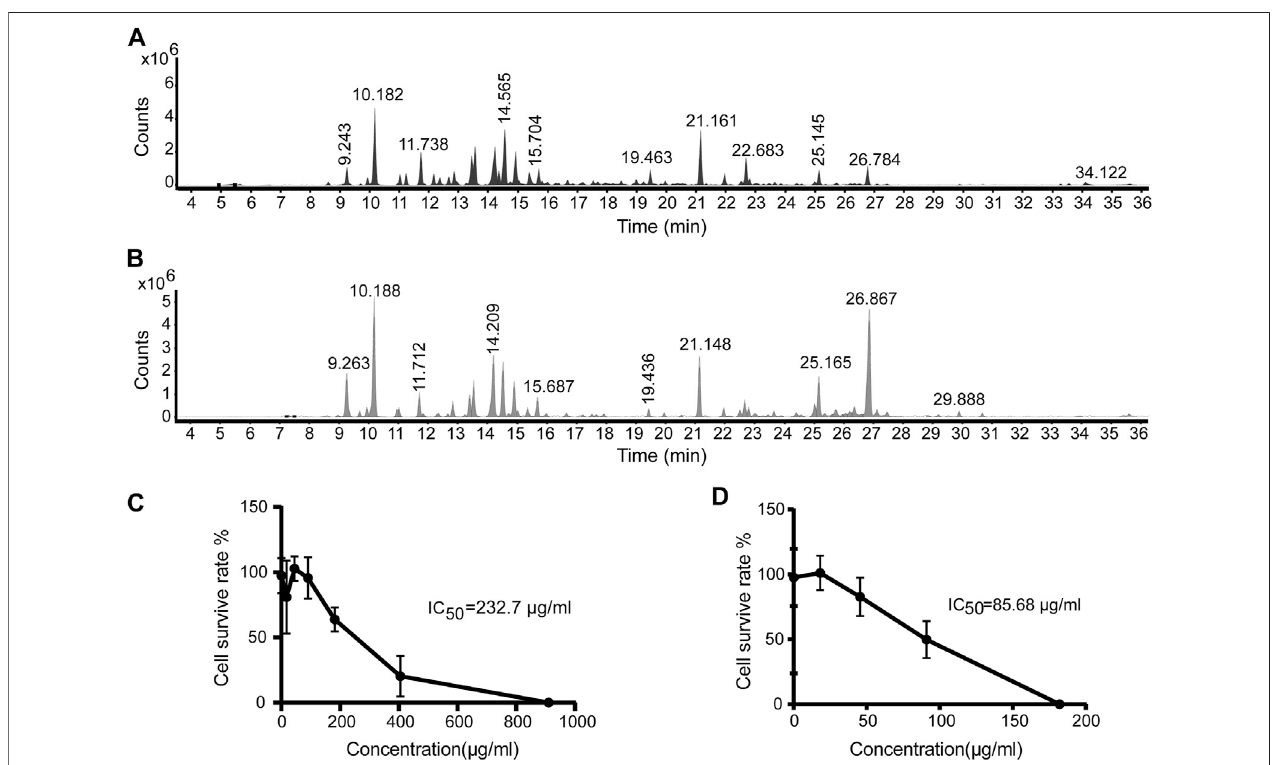
FIGURE1| GC-MS analysisofEOAAand theeffect ofEOAA oncellviability. Typicaltotalionchromatography(TIC)ofSFEAO (A) and SDAO (B) .THP-1cells were incubated with different concentrations of SFEAO and SDAO. The effect of SFEAO (C) and SDAO (D) on cell viability were determined by CCK-8 assay. IC 50 : the half maximal inhibitory concentration. Data were from three independent experiments with biological duplicates in each ( C , D ; mean and SD of n (cid:2) 6).